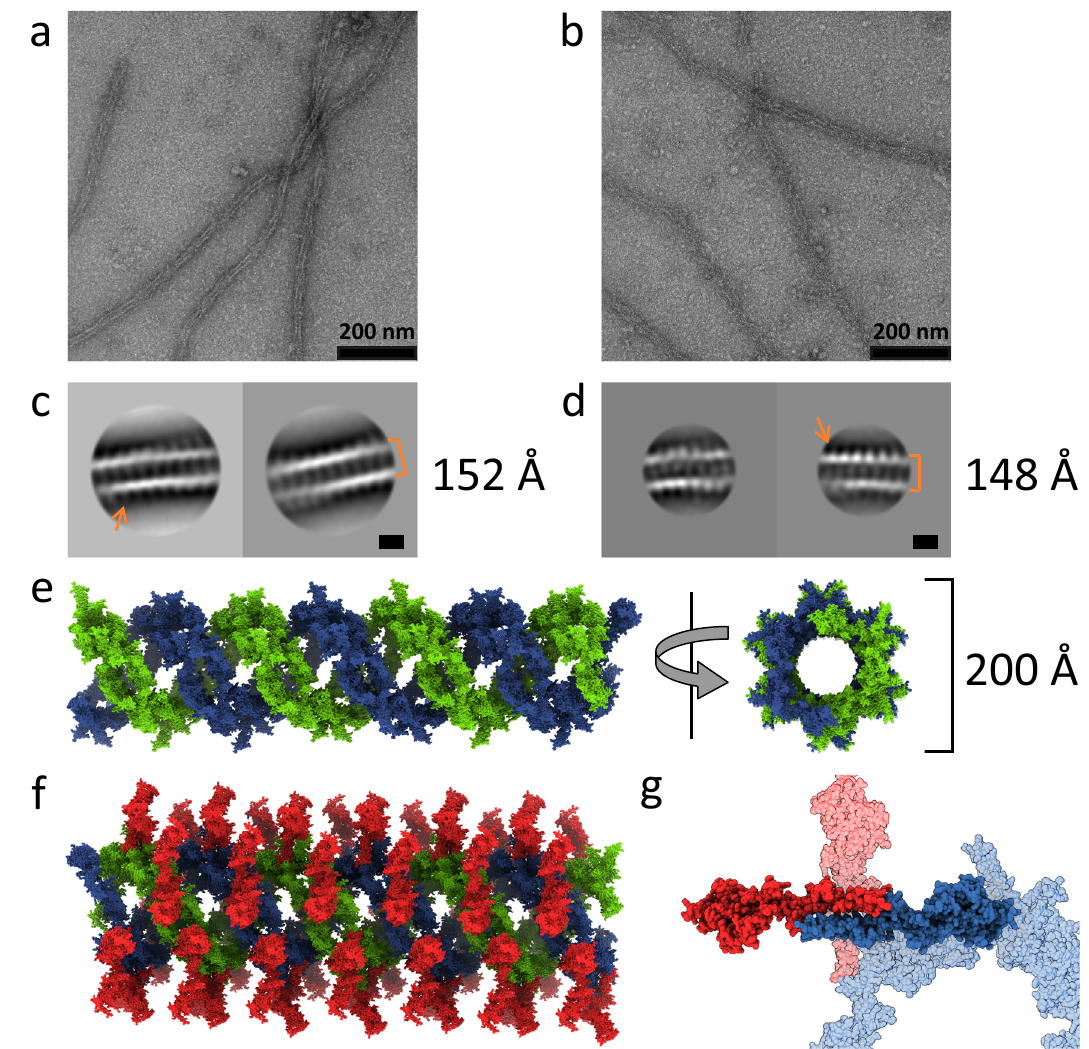
Fig. 2 | NET1 fi lament formation in the presence of heparin oligosaccharides. Representative negative stain images of NET1 Δ C ( a ) in comparison to full-length NET1 ( b ) upon the addition of HO-dp10. Images show the formation of extended, fi lament-like structures (scale bar 200nm). 2D class averages of NET1 Δ C fi laments ( c ) from ~3500 picked particles and class averages of full-length NET1 ( d ) from ~1500particles.Theseclassaveragesindicateatubularassemblywithapproximate outerdiametersof152Å(NET1 Δ C)and148Å(full-lengthNET1),andrepeatingunits projecting from the outside of the tube walls (arrows). Scale bars are